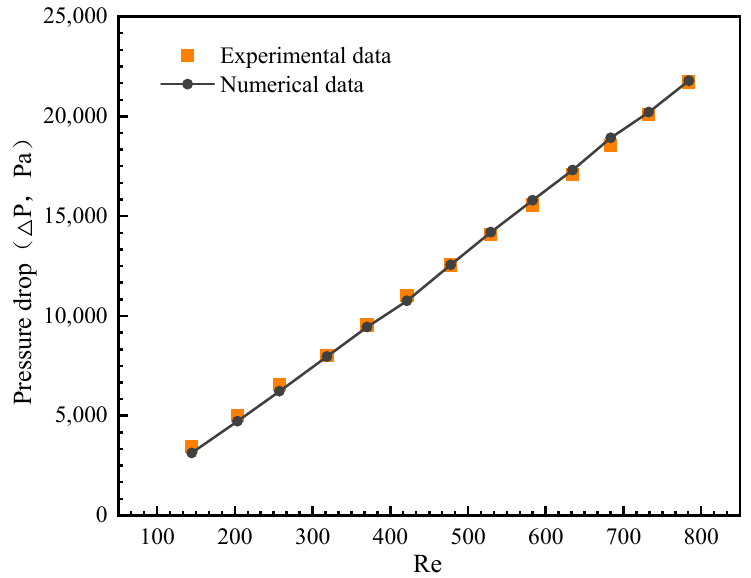
Figure 4. Comparison of pressure drop between simulation and experiment by Lee et al. [33].